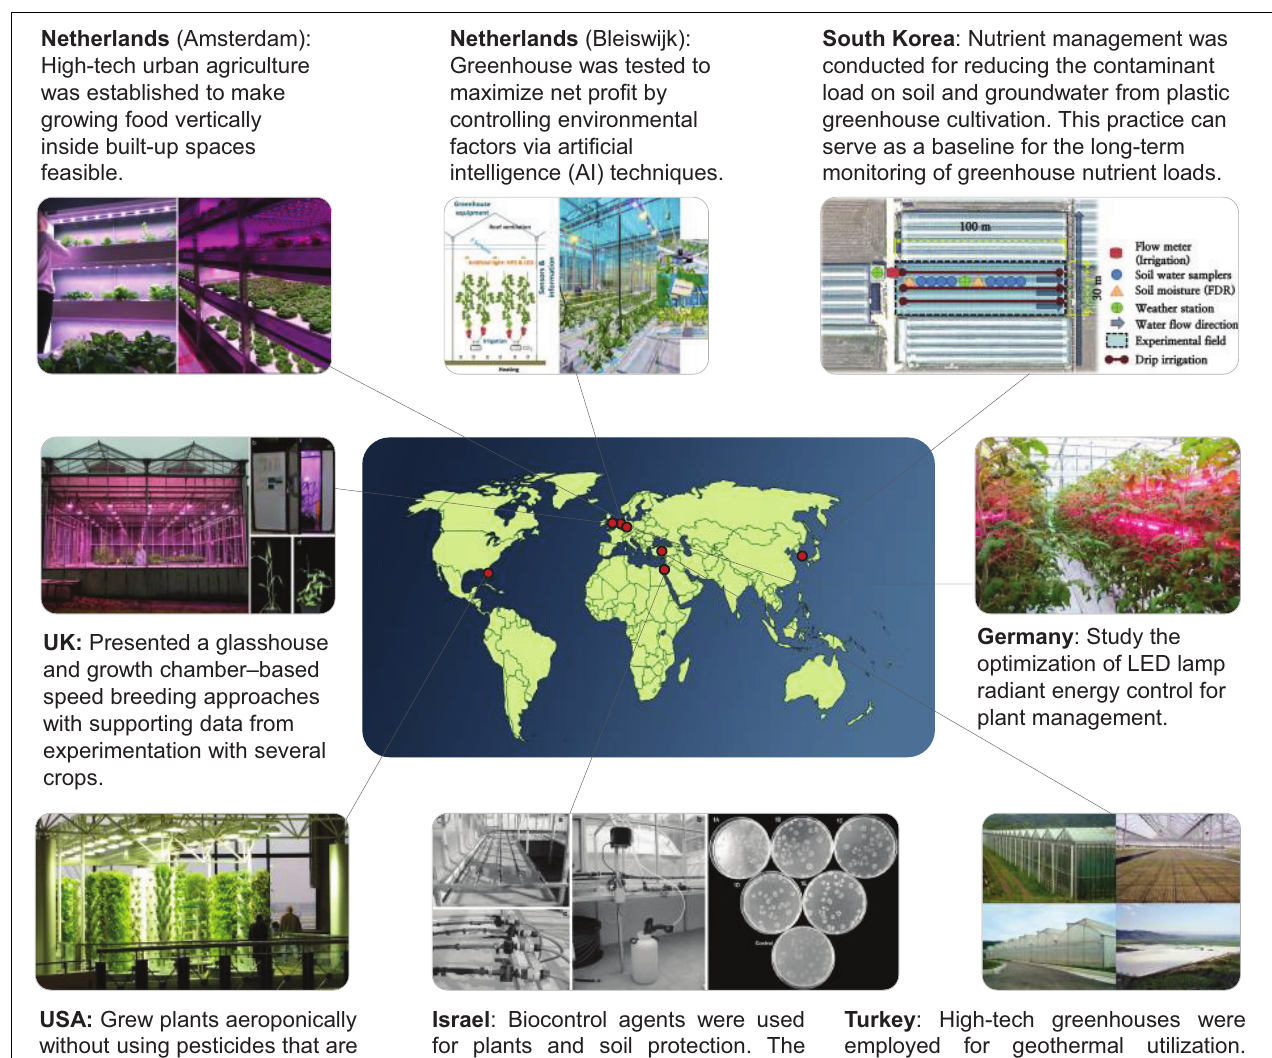
FIGURE 1 | Exploration and application of controlled environment agriculture (CEA) systems worldwide. The figure compiled information based on the following references: Boari et al. (2008), Hong et al. (2014), Eigenbrod and Gruda (2015), Tuzel and Oztekin (2016), Ghosh et al. (2018), Lakhiar et al. (2018), Farhangi et al. (2020), Hemming et al. (2020).